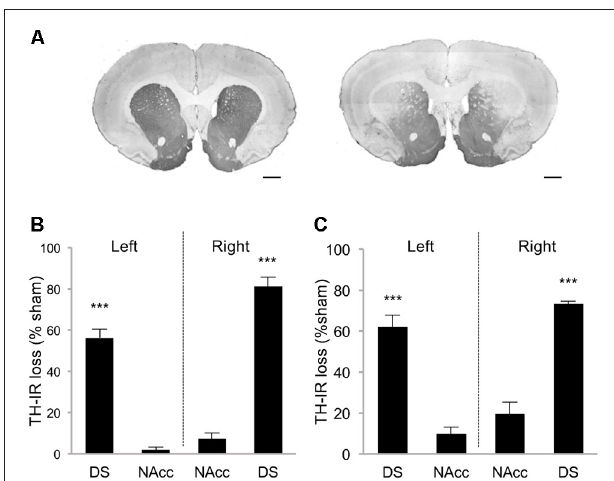
FIGURE 2 | Striatal tyrosine hydroxylase immunoreactivity (TH-IR) loss induced by 6-OHDA SNc lesion. (A) Representative photomicrographs of TH-immunostained striatal coronal section of sham rat (left picture) and 6-OHDA lesioned rat (right picture). Quantification of TH-IR loss in DDT within-session experiment (B) and between-session experiment (C) . Data are expressed as the percentage of the mean optical density value obtained for sham rats on the AP levels +2, 2; +1, 6; +0, 7. ± SEM. ∗∗∗ p < 0.001. DS, Dorsal striatum; NAcc, Nucleus accumbens. Scale bar: 1